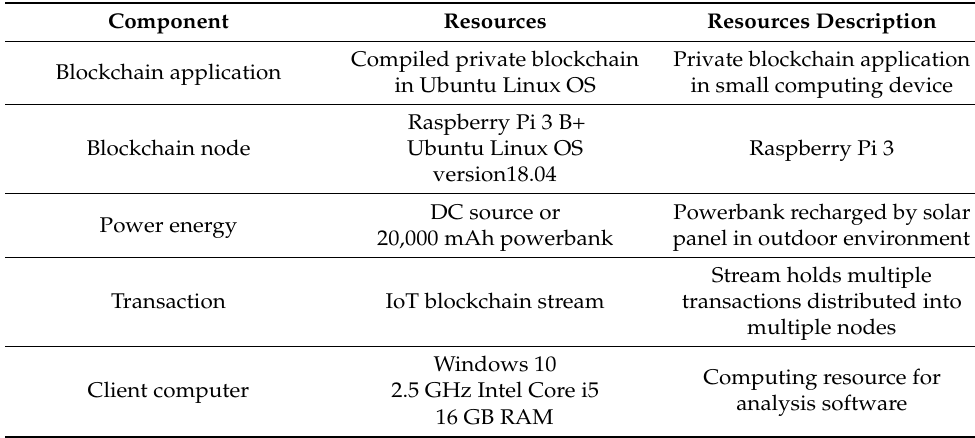
Table 4. Specifications of IoT blockchain intelligent small computing